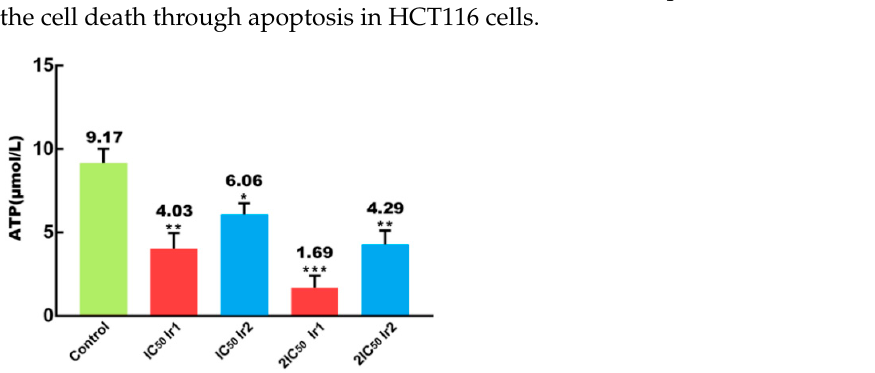
Figure 7. Intracellular ATP content analysis after a 24 h treatment of HCT116 cells with IC 50 and 2IC 50 of Ir1 and Ir2 for 24 h. * p < 0.05, ** p < 0.01, *** p <